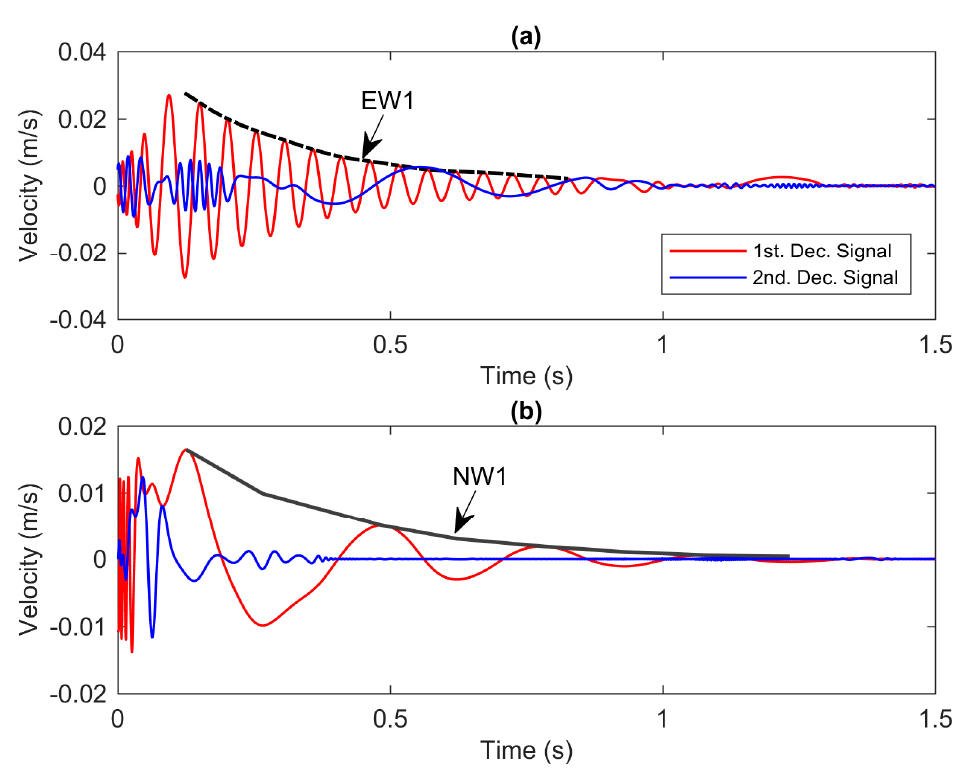
Figure 10. The decomposed signals of ( a ) the experiment model and ( b ) the numerical model.